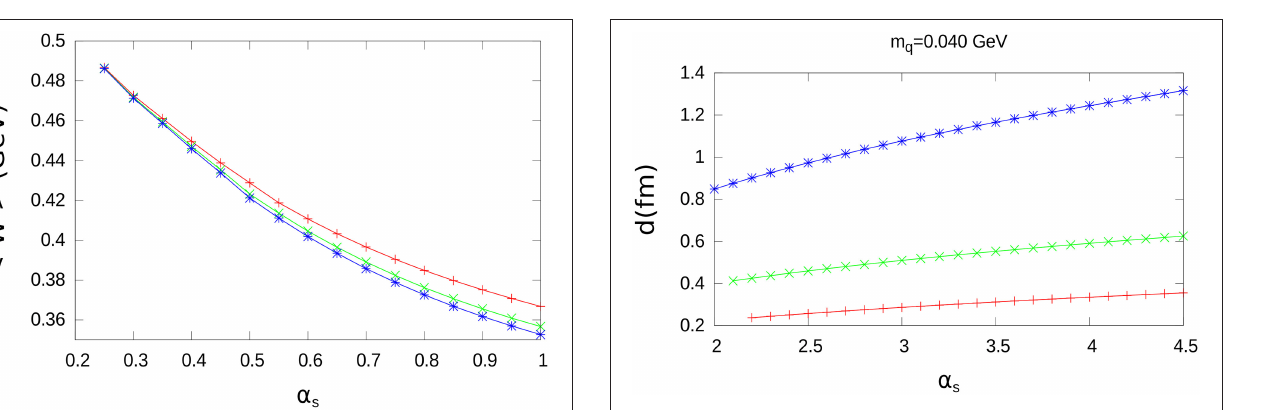
1.086 GeV as the three quark =